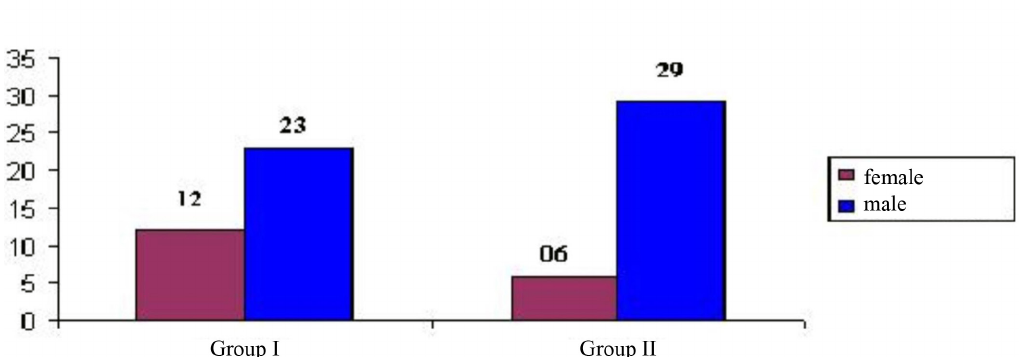
Fig. 1 - Characterization of groups by gender.